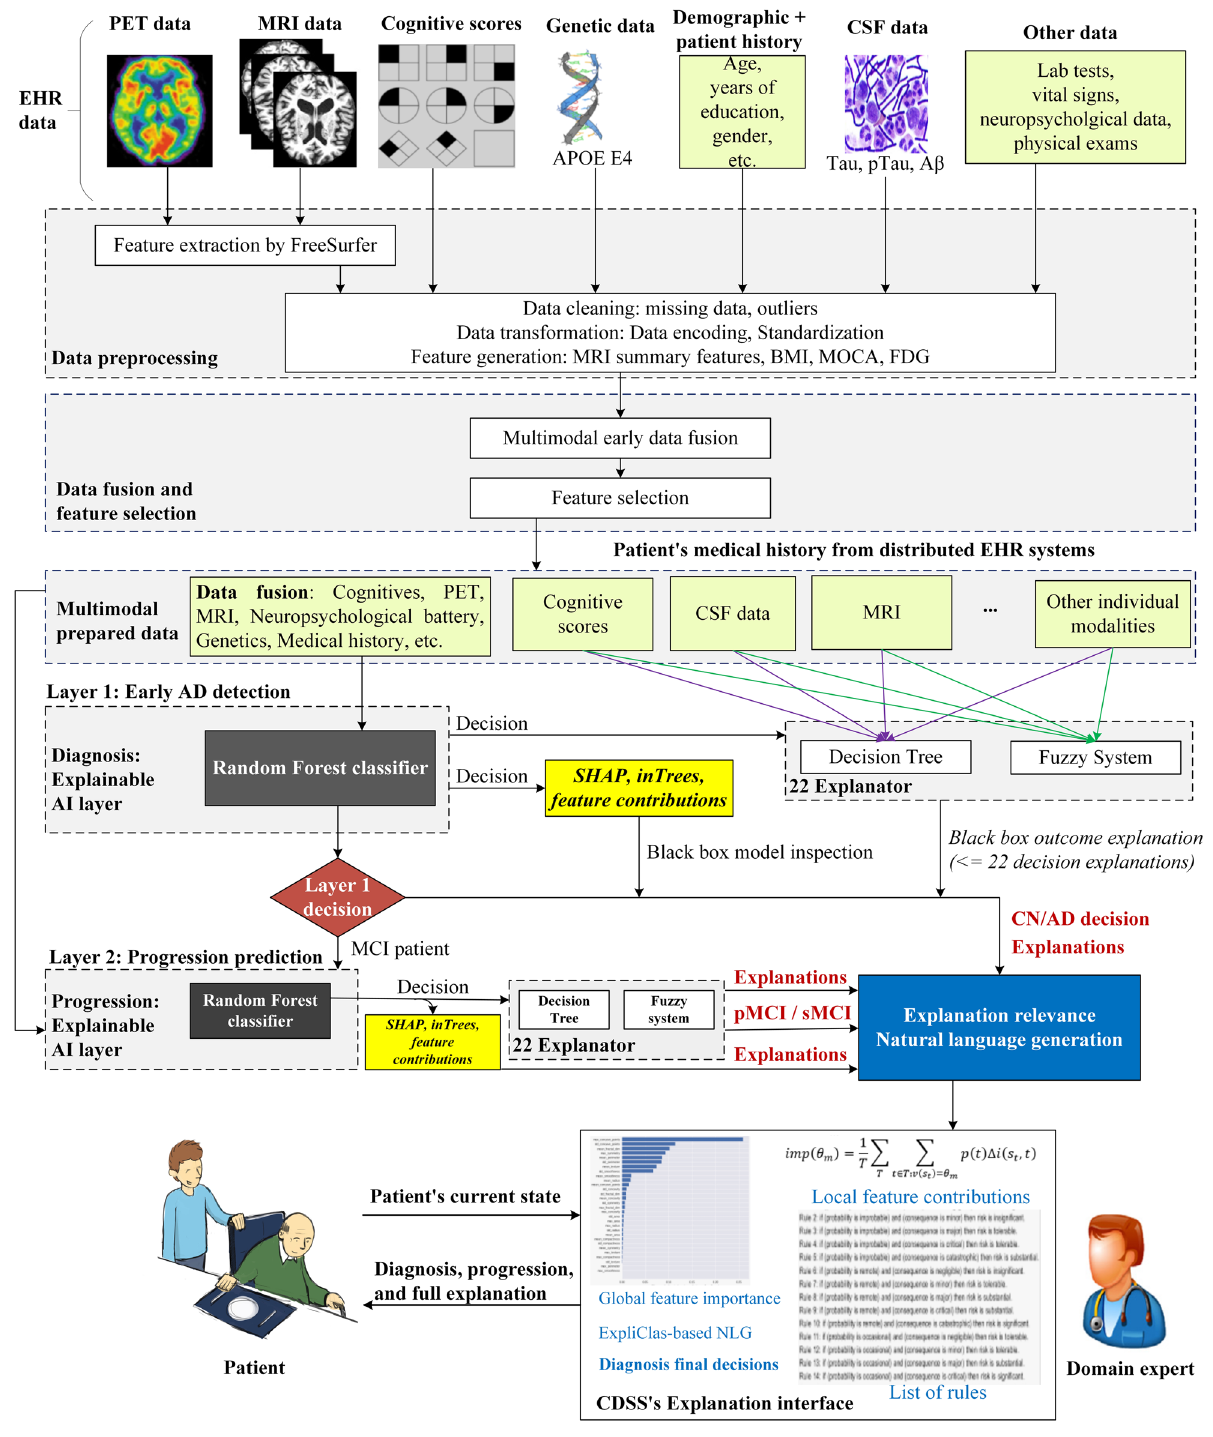
Figure 6. The proposed XAI framework. A variety of data modalities are used to build the predictive model. In addition, a variety of explanations are built for the entire RF behavior and for each prediction. The FreeSurfer version 6.0 is used (https ://surfe r.nmr.mgh.harva